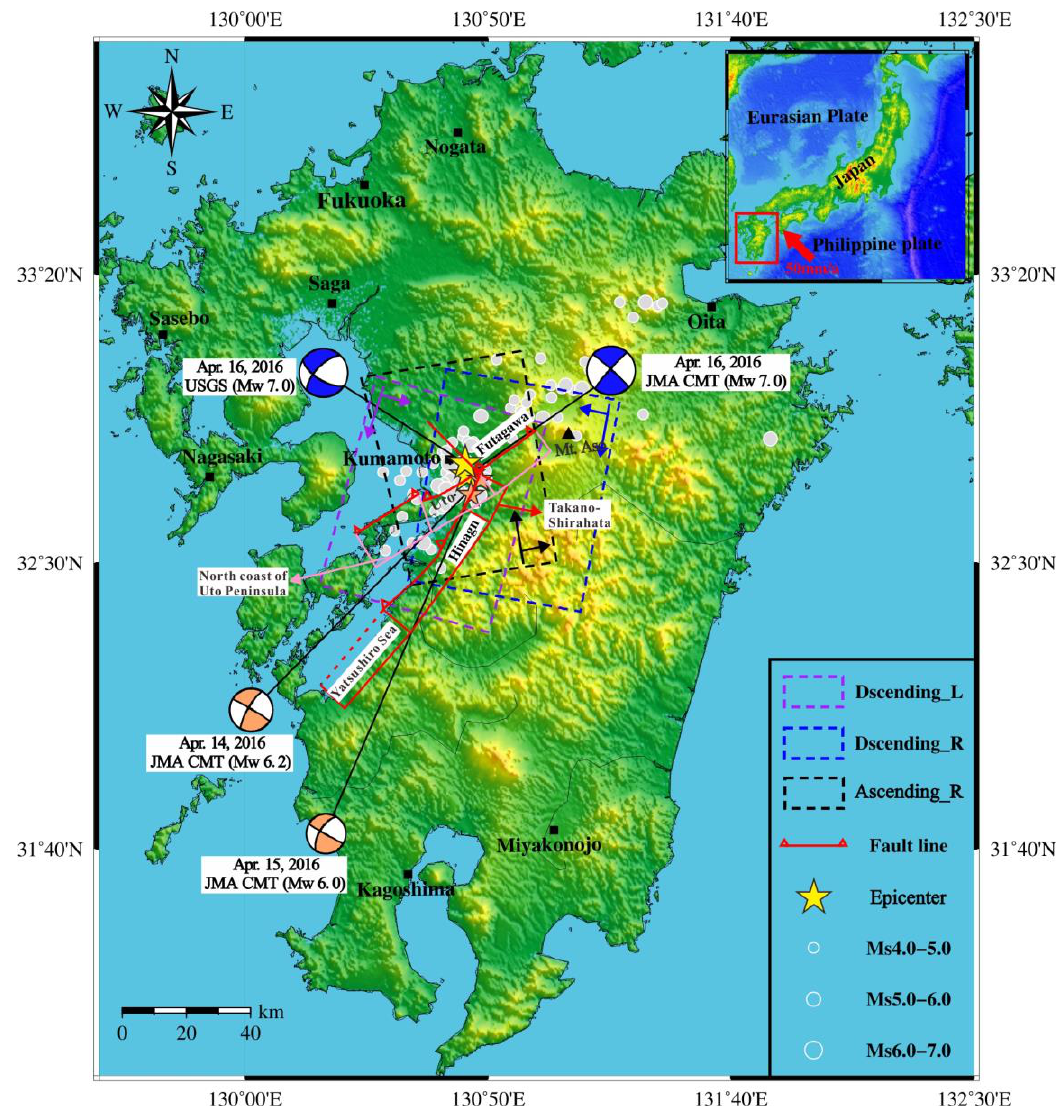
Figure 1. Location map of the 2016 Kumamoto earthquake. Beach balls in blue indicate the source mechanisms of the mainshock solved by the United States Geological Survey (USGS, available at https://earthquake.usgs.gov, accessed on 12 May 2021) and Japan Meteorological Agency (JMA, available at http://www.data.jma.go.jp/svd/eqev/data/mech/cmt/ cmt201604.html, accessed on 12 May 2021). Beach balls in orange indicate the source mechanisms of the two foreshocks. Gray solid circles represent the epicenters of aftershocks with magnitudes larger than 4.0. Red lines denote surface traces of the Futagawa and Hinagu faults [16,22]. Purple, blue, and black dotted rectangles indicate the ground coverage of used SAR images. The black triangle indicates the Aso